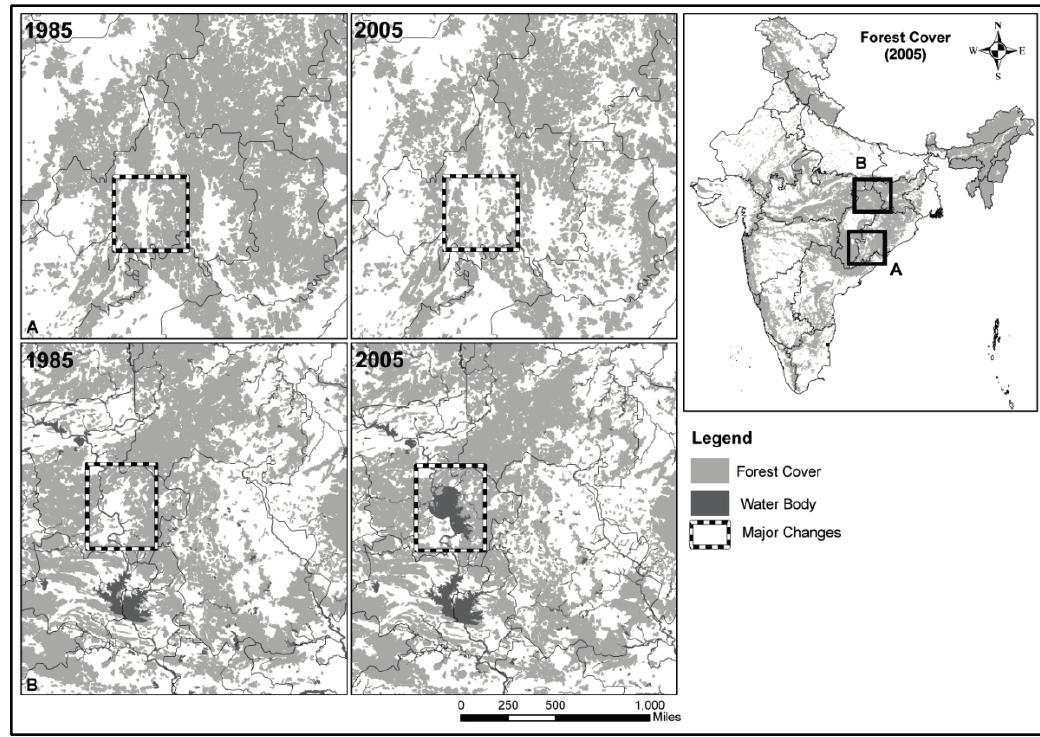
Figure 6. Loss of forest cover in central India during 1985 – 2005.